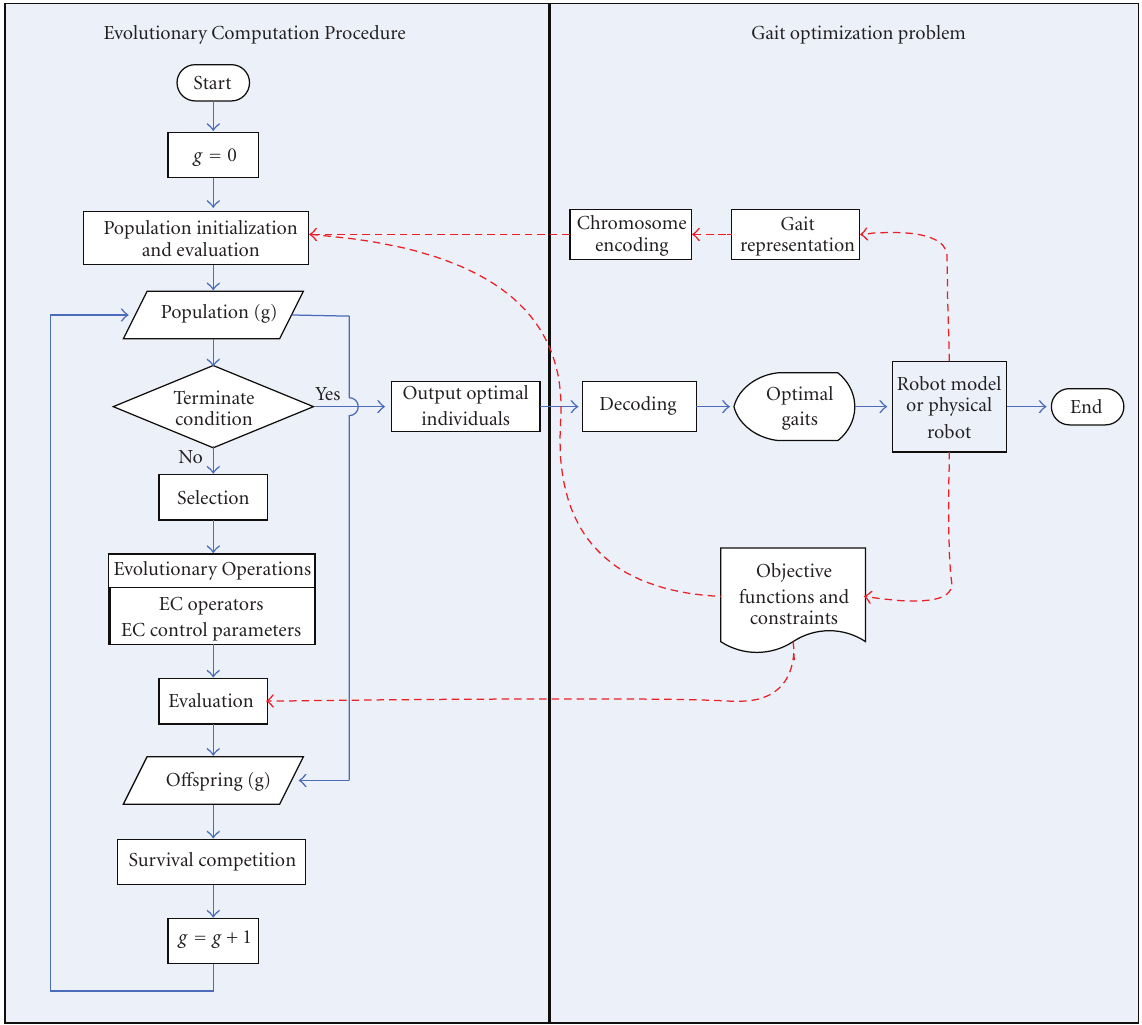
Figure 1: A general block diagram for EC-based gait